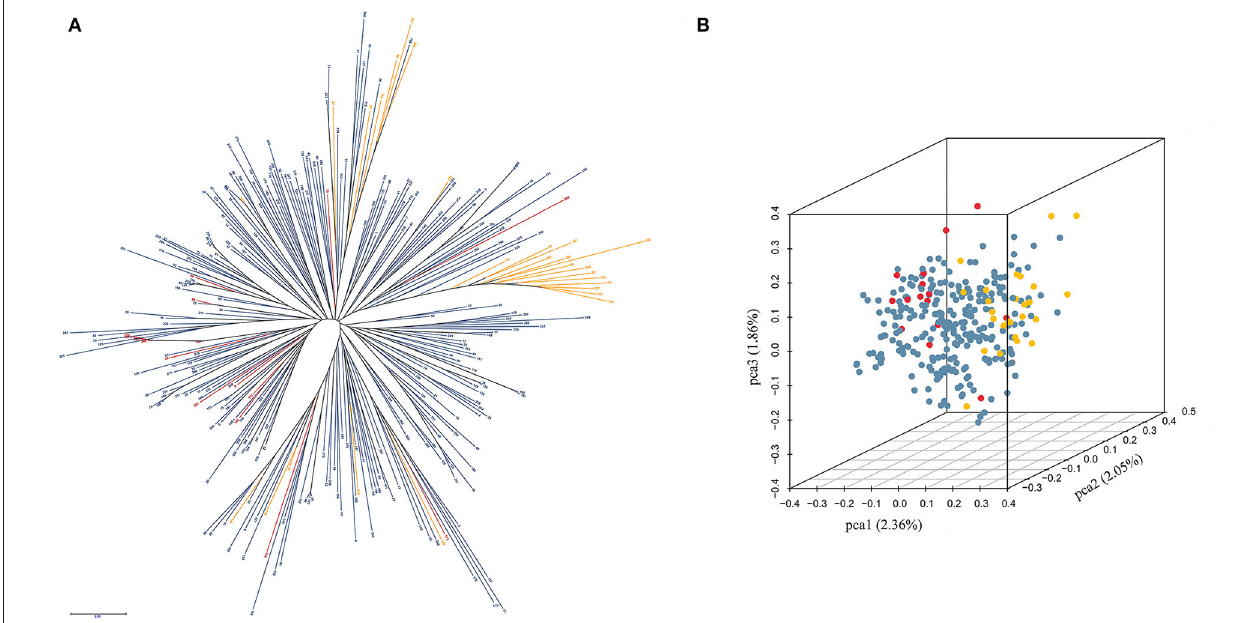
FIGURE 2 | Clustering and PCA analysis in 300 accessions of B. napus. (A) Clustering analysis in 300 accessions of B. napus ; (B) PCA analysis in 300 accessions of B. napus . The yellow, blue, and red indicate winter, semi-winter, and spring ecotypes of B. napus , respectively.